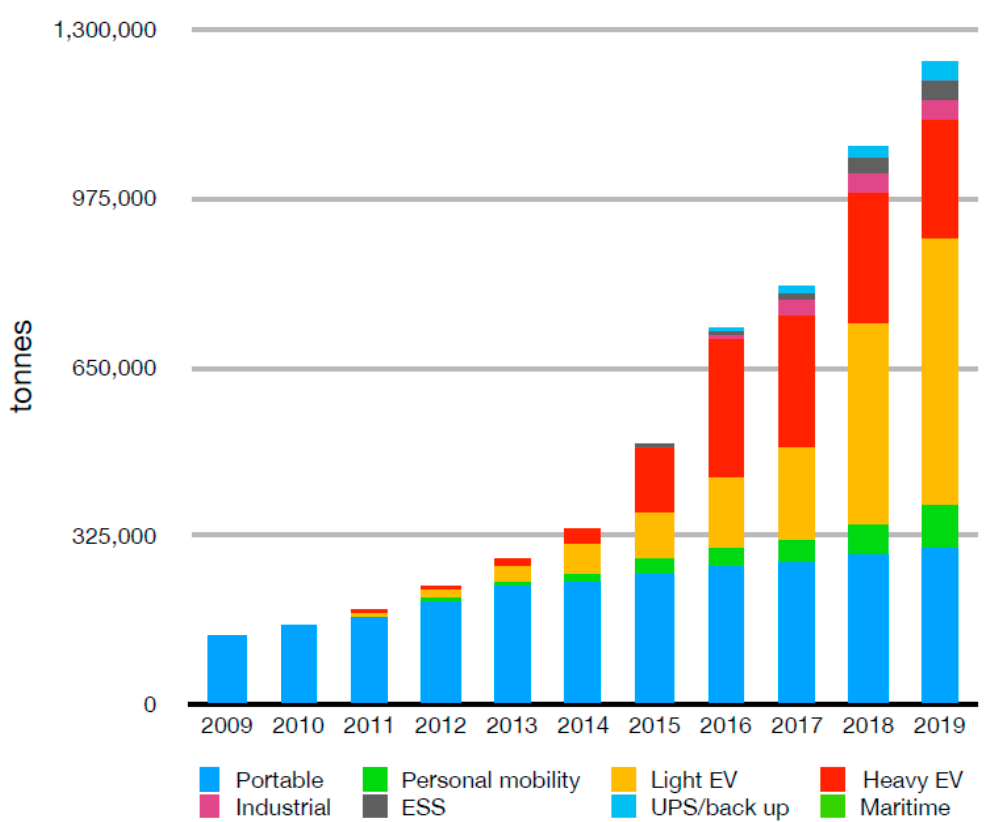
Figure 1. Lithium-ion batteries placed on the global market, 2009–2019, in tonnes, at the cell level by application (courtesy of Circular Energy Storage).